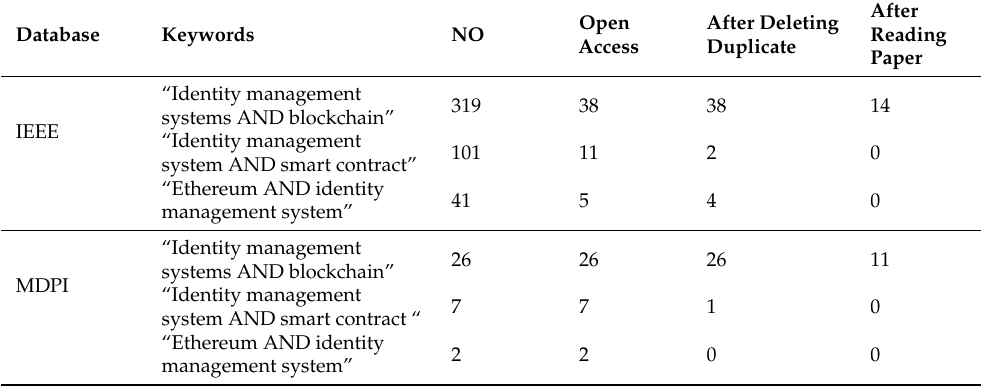
Table 2. Research String.